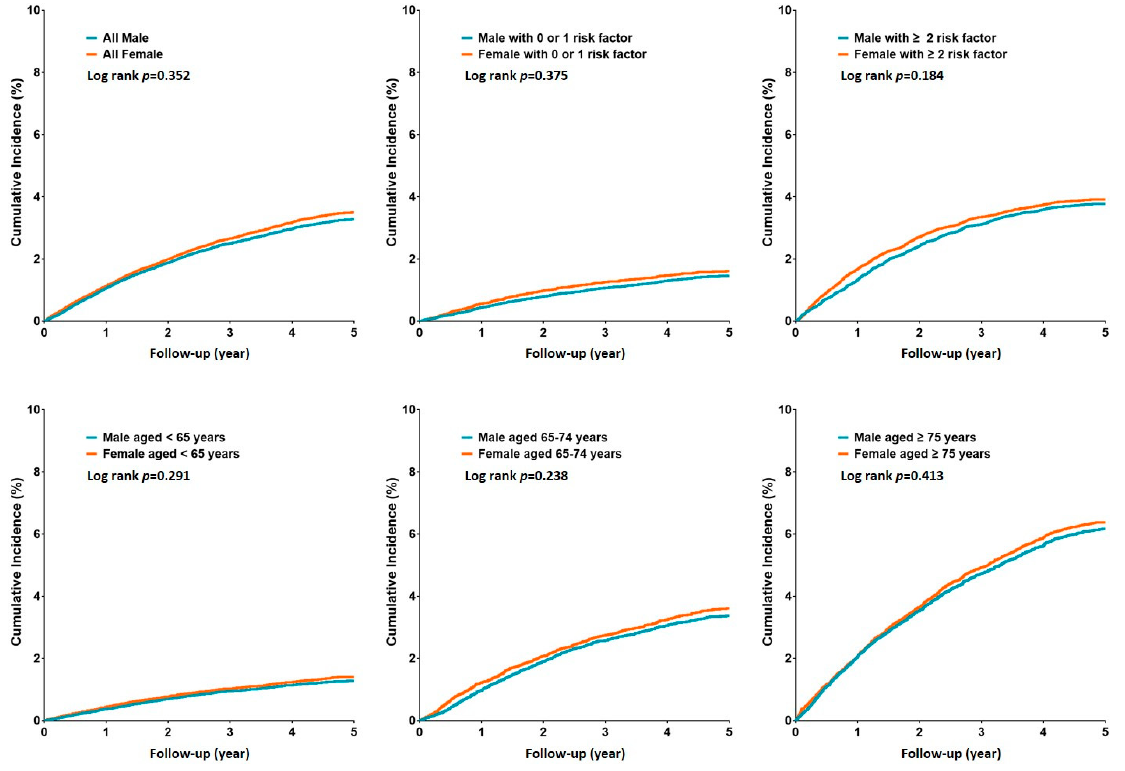
Figure 2. Cumulative incidence curves for ischemic stroke in male and female patients stratified by risk factor components and age groups.